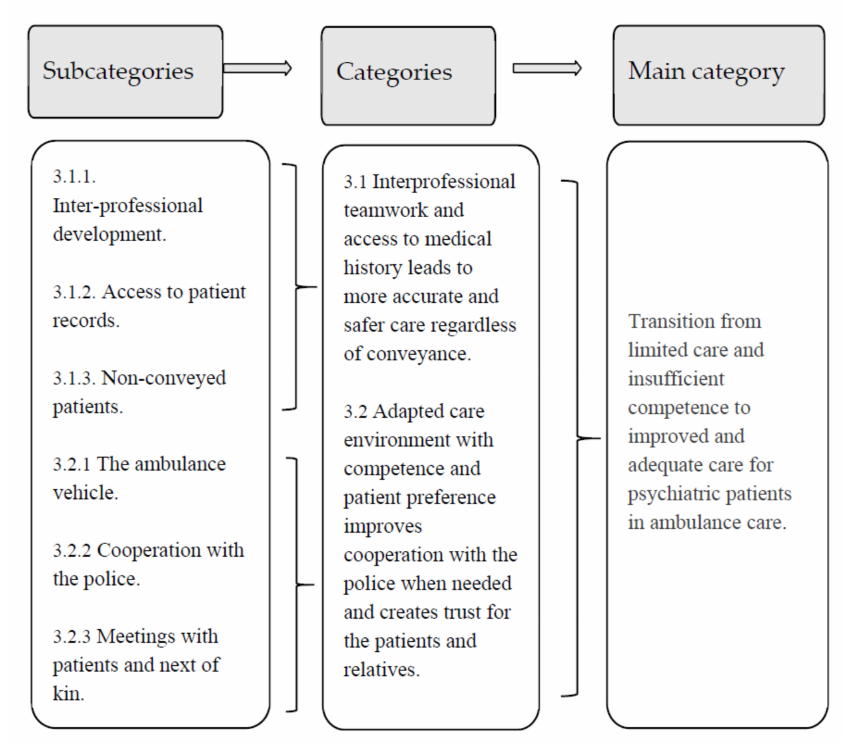
Figure 1. Subcategories, categories, and main theme based on the prehospital emergency nurses’ overall perception of their working experiences in a psychiatric emergency response